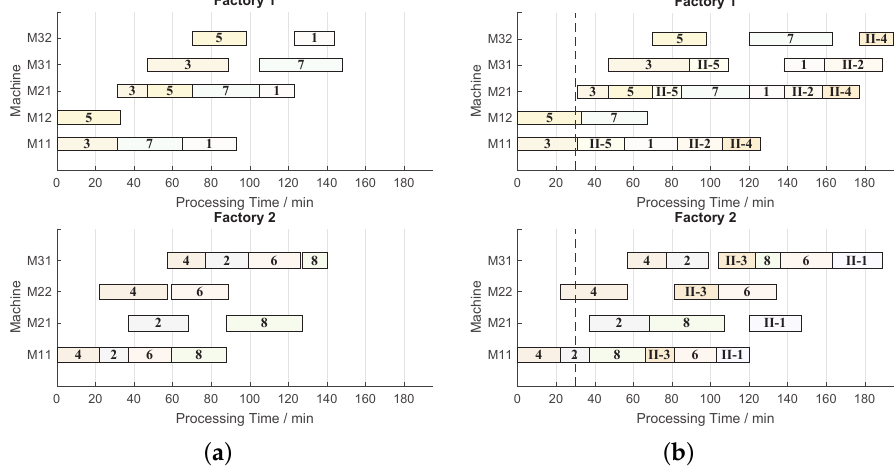
Figure 1. Gantt chart of an instance of EDHFRP; ( a ) Original schedule; ( b )